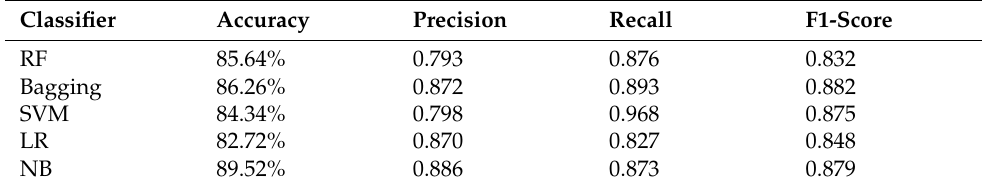
Table 15. Experiments with ML models and TF-IDF on Arab TextBlob sentiments.